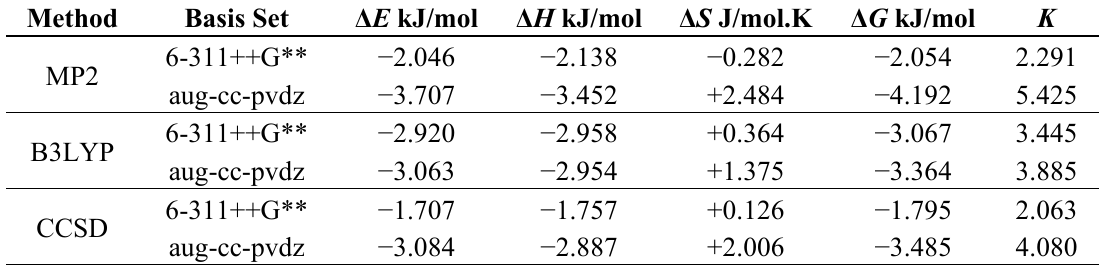
Table 4. MP2, B3LYP and CCSD methods with 6-311++G** and aug-cc-pvdz basis sets zero-point Reaction Energies, Enthalpies, Entropies, Free Energies Changes